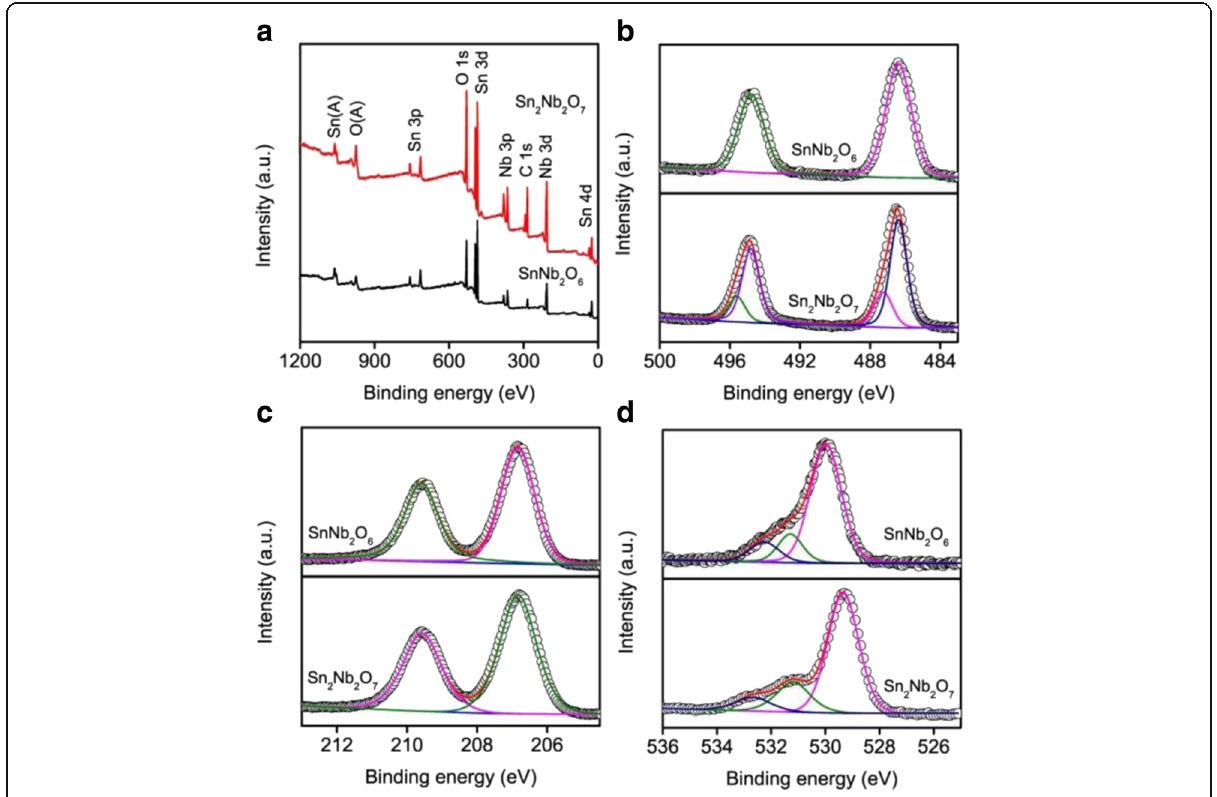
Fig. 4 XPS spectra of SnNb 2 O 6 and Sn 2 Nb 2 O 7 . a Survey spectrum, b Sn 3d, c Nb 3d, and d O